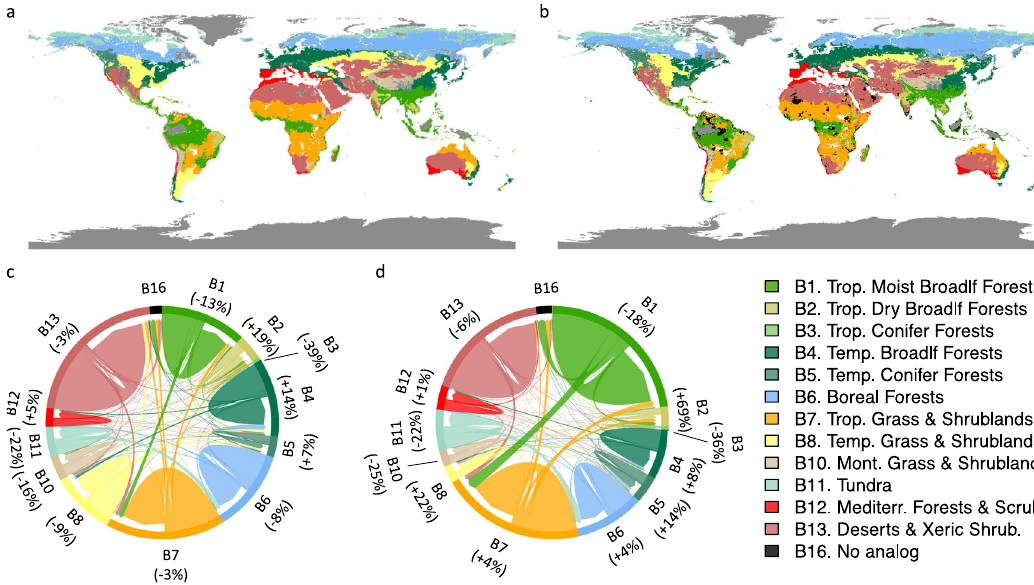
Fig. 3 Biome-level state and transitions under a + 2 °C warming scenario. Current biome distribution ( a ), projected future distribution ( b ), state and transitions for all terrestrial lands excluding protected areas ( c ), and within protected areas ( d ). For chord diagrams, the relative magnitude of biome-level fl uxes is shown by the width of arrows between biomes. The net change in biome area (percent) is shown in parenthesis. The proportion of the circle ’ s circumference associated with a given biome indicates the total amount of land area that is or will be in that biome. Current biome land area is the circumference proportion from which arrows of that biome ’ s color originate; future biome land area is the circumference proportion of that biome ’ s color to which arrows of any color point. Arrows that start and end at the same color represent areas that do not undergo a biome-level